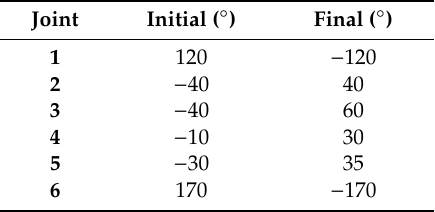
Table 4. Initial and final joint angle.